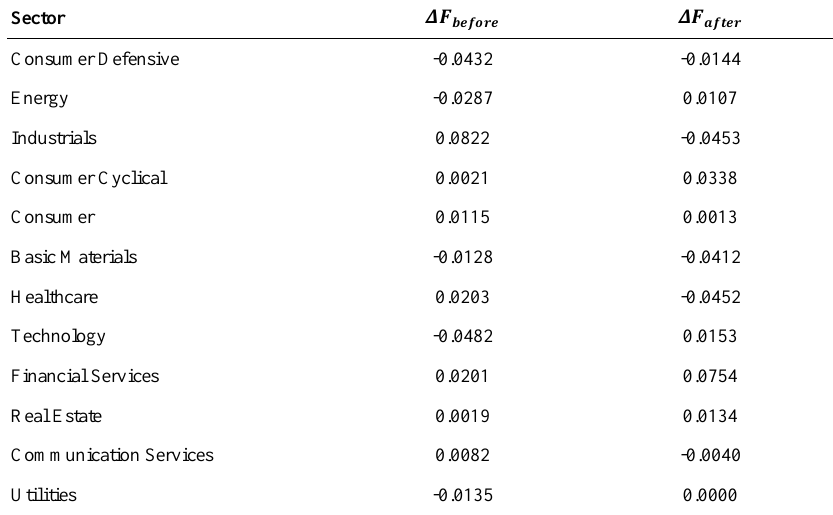
Table 8. The net information outflow for the sectors in Nikkei market, before and after COVID-19 outbreak